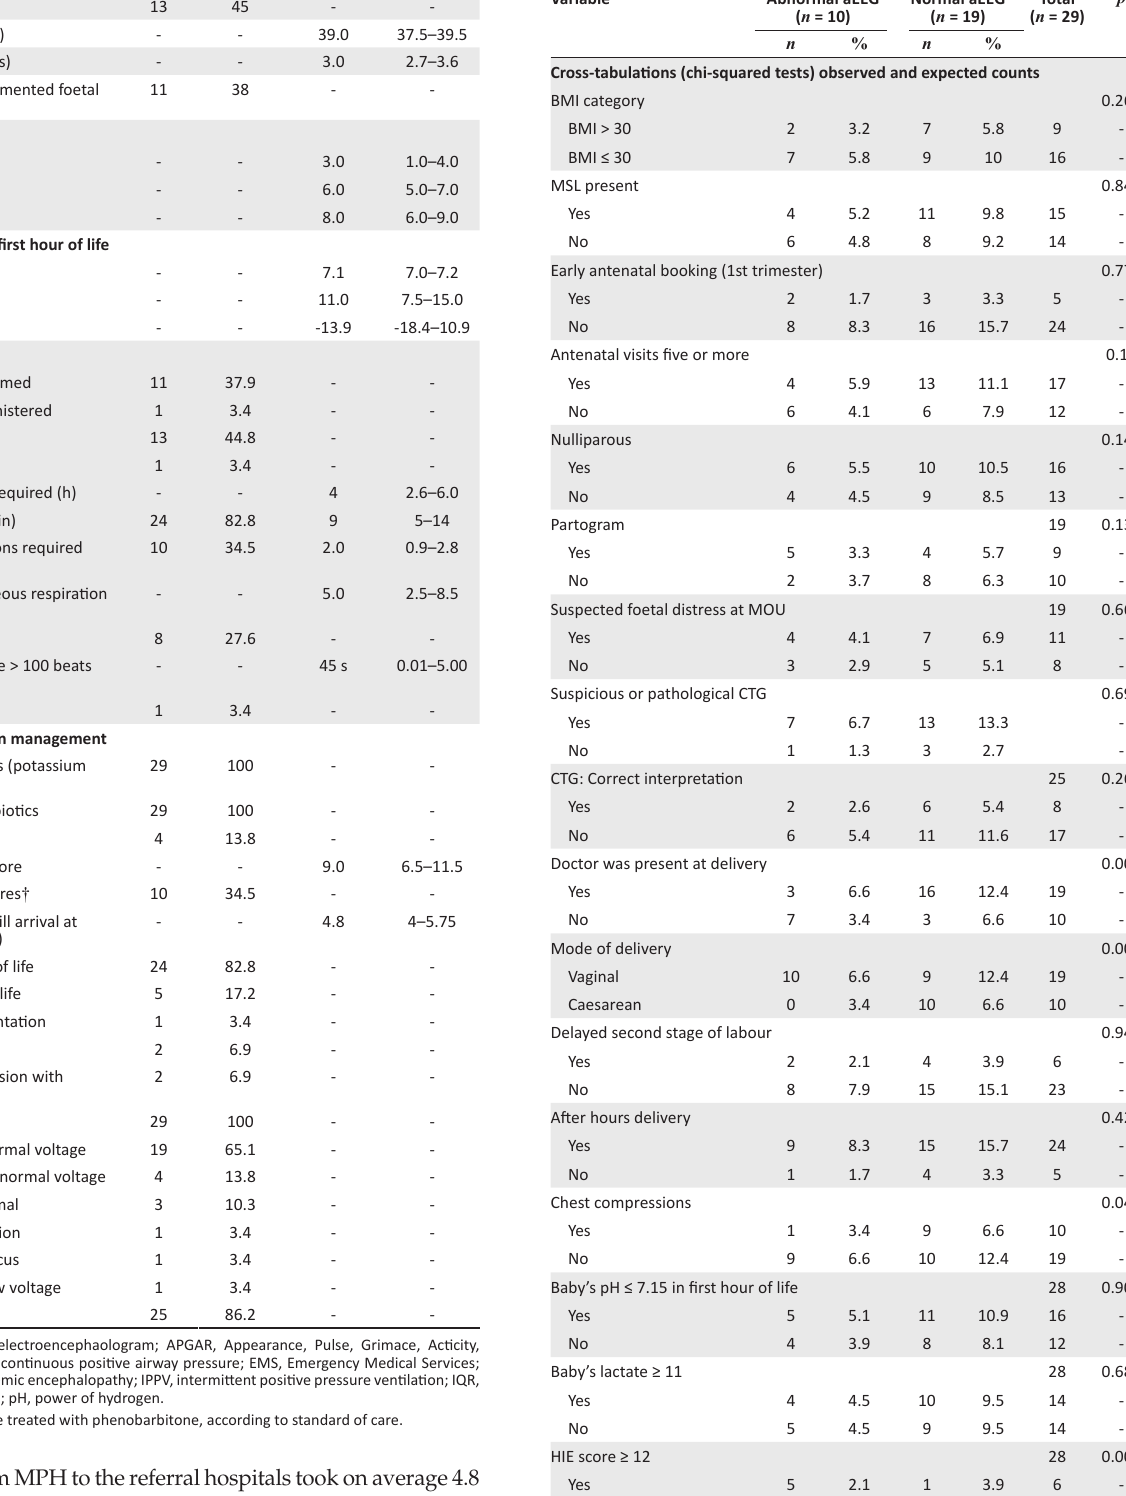
TABLE 4: Details describing the babies’ clinical and therapeutic course from birth to day seven of life. Features